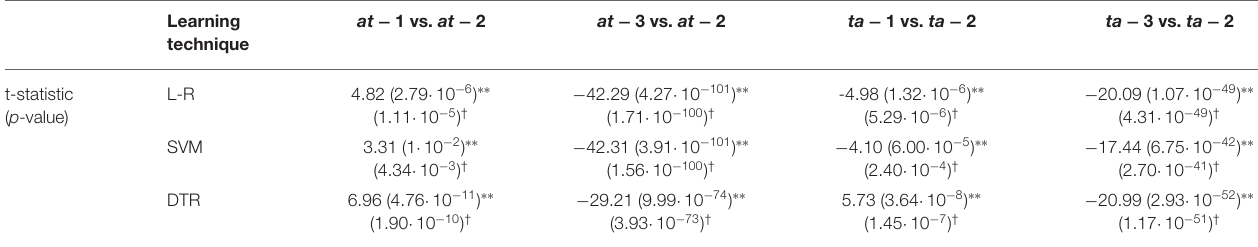
TABLE 6 | The two-tailed t -test between alpha and theta band ratios: at − 1 vs. at − 2: 2-tail test value between indexes at − 1 and at − 2. at − 1 vs. at − 2 at − 3 vs. at − 2 Learning technique t-statistic ( p